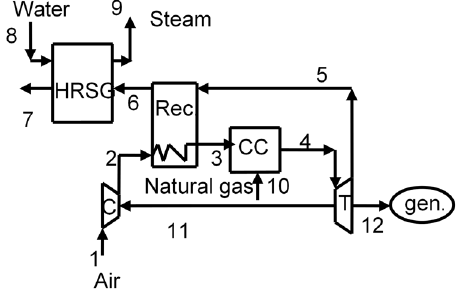
Figure 2: Schema of an air heating ( ah ) cogeneration